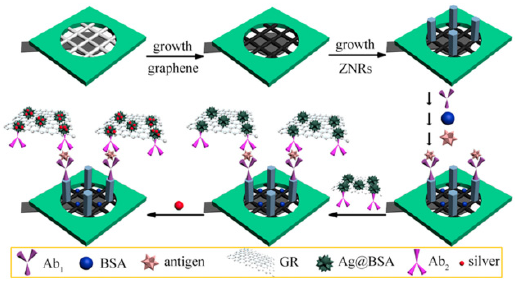
Figure 7. The fabrication process of the multiplexed enzyme-free electrochemical immunosensor based on the BSA-stabilized silver nanoparticles (reprinted with permission from Ref. [89], Copyright 2015, Elsevier).